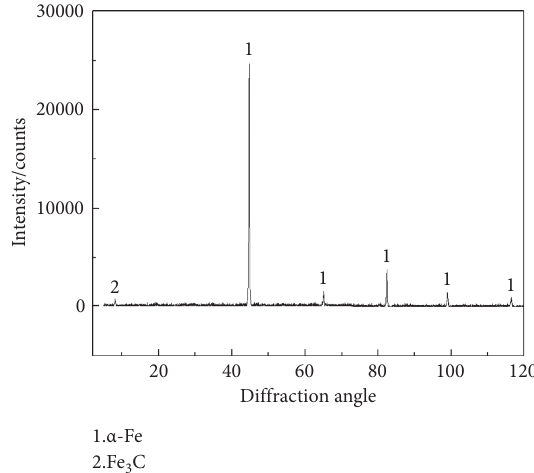
Figure 3: XRD pattern of grade-A ship